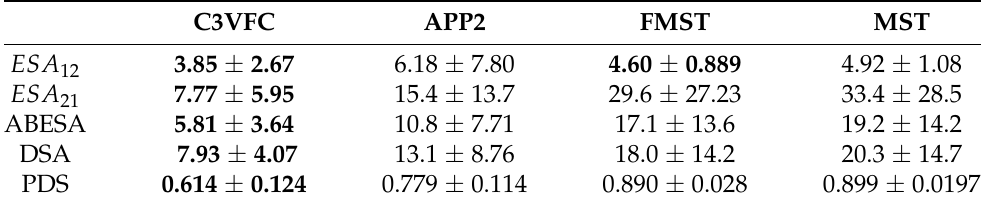
Table 1. Performance evaluation of results. The five measures computes the distance of the baseline manually traced results to the results from the respective methods. A lower value signifies better performance for all distance measures. The values in bold signify the best scores for each